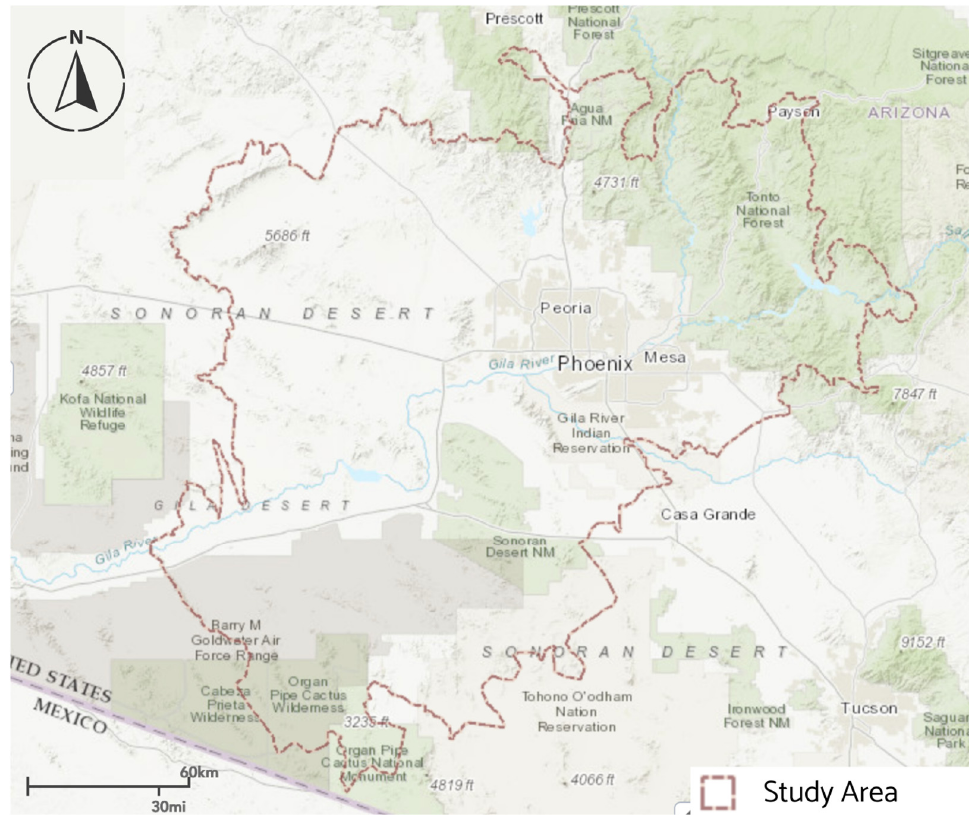
Figure 2. Map of the CAZCA study area in Arizona, USA.